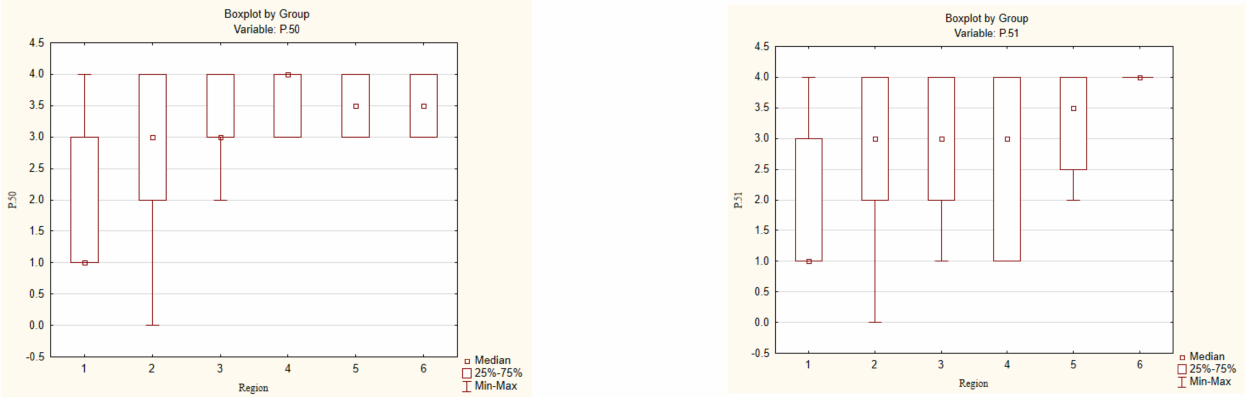
Figure 15. Box and whisker diagrams by practices P50 (Doing car checks regularly), P51 (Avoiding overloading the car), category “Mobility”.